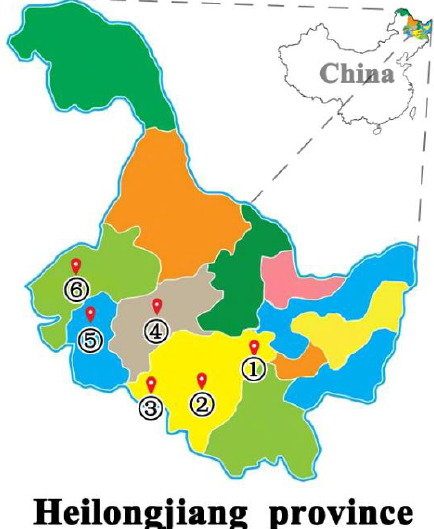
Figure 1. Geographical distribution of the farms where the experimental samples were collected. Numbers 1–6 represent the different farms where samples were collected and the number of samples; 1: Harbin-1 (40), 2: Harbin-2 (26), 3: Harbin-3 (44), 4: Suihua (4), 5: Daqing (40), 6: Qiqihar (178).